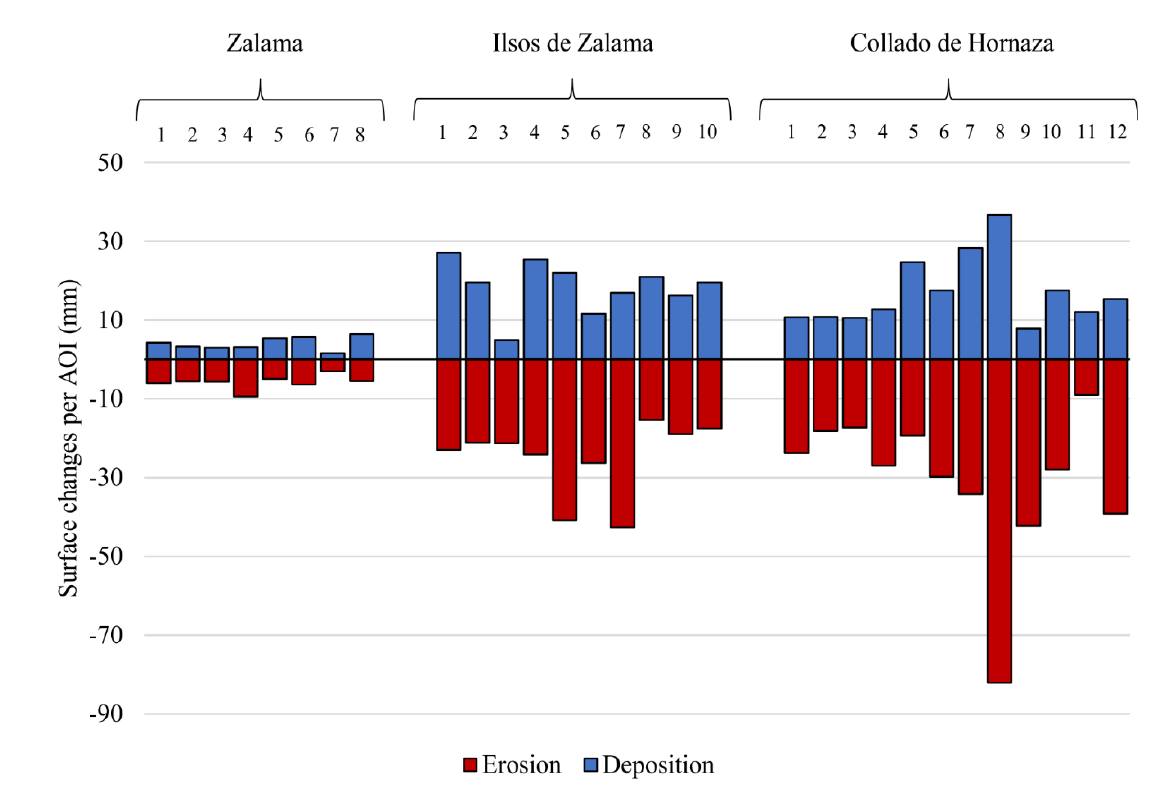
Figure 6. Mean positive (deposition) and mean negative (erosion) surface change measured by